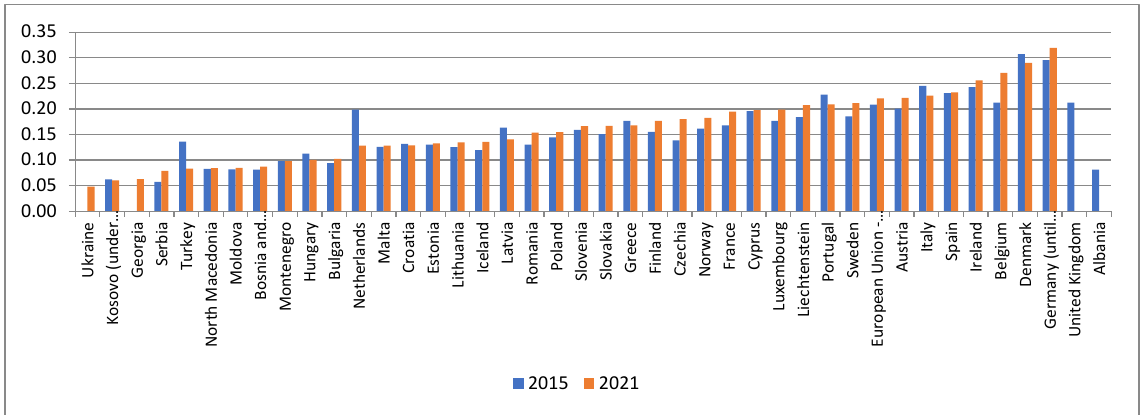
Figure 7. Average electricity prices (without taxes) for household consumers in 2020 (in EUR, per kWh). Source: own preparation based on Eurostat database [47].